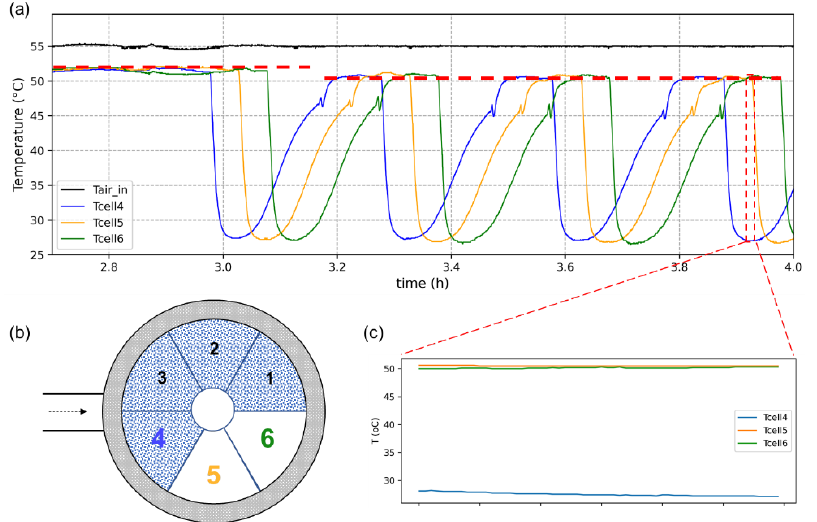
Figure 5. ( a ) temperature profiles of inlet air, Cell4, 5, and 6 in preheating and drying, ( b ) schematic diagram of cell states (filled state in blue or empty state in white), and ( c ) temperature profiles of Cell4, 5 and 6.